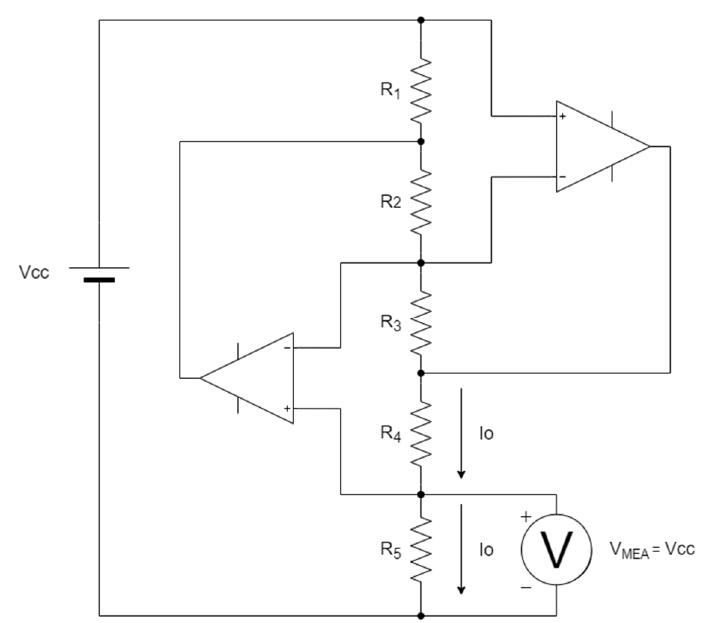
Figure 3. Generalized Impedance Converter. Electronics 2020 , 9 , x FOR PEER REVIEW